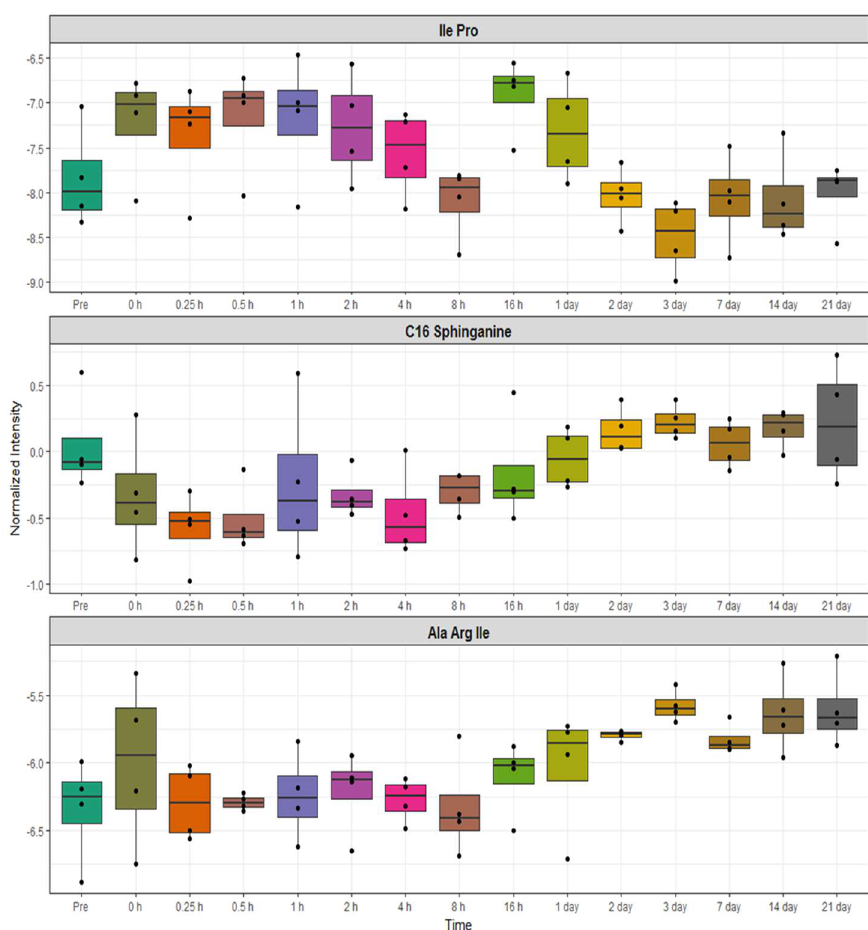
Figure 7. Box and whisker plot representation of oscillatory changes in serum metabolite profiles up to 21 days after oral administration of BIO 300.